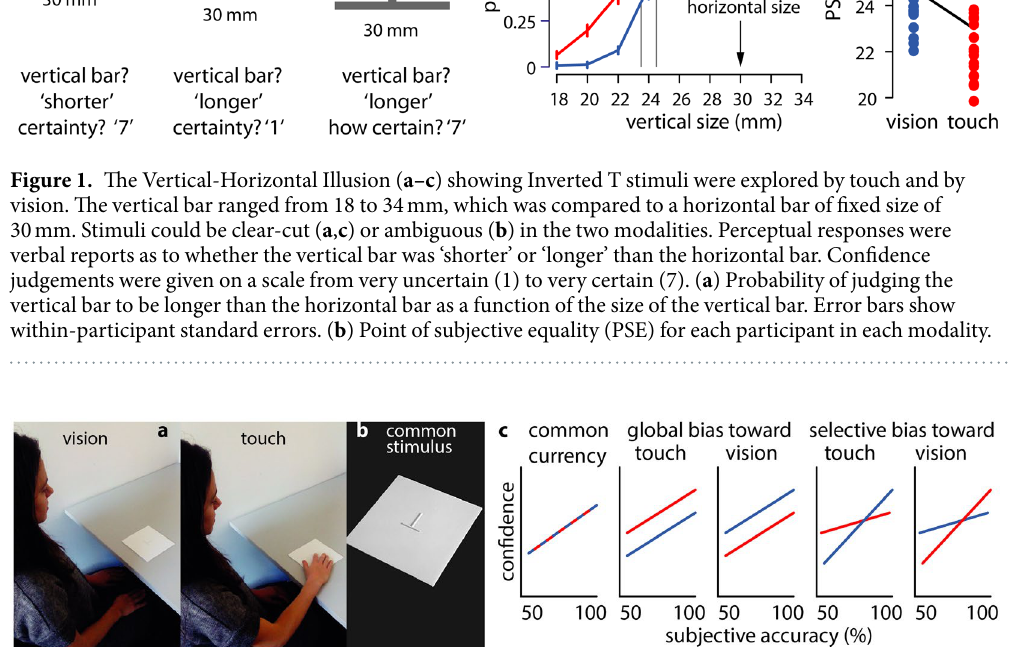
The study of confidence falls within the field of metacognition, i.e. how the cognitive system assesses and mon- itors its own states 19–21 . Studies comparing perceptual confidence across sensory modalities have been conducted previously but for tasks where each modality could not be directly compared, i.e. in a brightness versus pitch discrimination 22 , or orientation versus pitch discrimination. According to a widespread account of perceptual metacognition, a central purpose of explicit judgements of confidence is to allow the reliability of perception across different decisions to be compared, and appropriate trust to be placed in each percept accordingly. The idea that confidence operates as a common currency at a given time across sensory modalities such as vision and audition has been directly tested by showing that people can determine which of two decisions should be trusted more both in the same modality as well as in different modalities 23,24 . By extension, the common currency model may extend through different decisional times by assuming that performance is mapped onto confidence in an identical manner across modalities. Decisions reached through different channels or in different contexts could then be compared. An ideal observer should then be able to decide which of two independent decisions to trust more, based on these comparable confidence ratings. This is this common mapping assumption that we tested across touch and vision. If an observer makes correct decisions about three times out of four, both in vision and touch, and if confi- dence follows a common mapping, we would expect the observer to report the same confidence in her decisions, no matter what modality is used to arrive at a judgment, so long as the probable correctness of her decisions remains the same. If she was only correct two times out of four when relying on touch, and three out of four when relying on vision, she should report lower confidence for touch than vision. These two ratings would mean that she should choose to rely on vision, rather than touch. In other words, for confidence to be comparable between decisions, observers’ confidence ratings are expected to track the probability of their response being correct for a given stimulus, regardless of the modality used: they should express similar confidence when making decisions similarly likely to be correct, and different confidence when differently likely to be correct. Though individuals differ in their mappings from correctness to confidence, both in bias and sensitivity, a common mapping is indeed observed in the same individual across independent tasks and comparable sensitivities 22 . It is then likely to sub- serve the use of confidence as a common currency in direct comparisons. There are several of ways in which the behavior of observers could depart from these assumptions (Fig. 2c). They could simply be over- or under-confident in one modality, causing them to rely on the corresponding sense